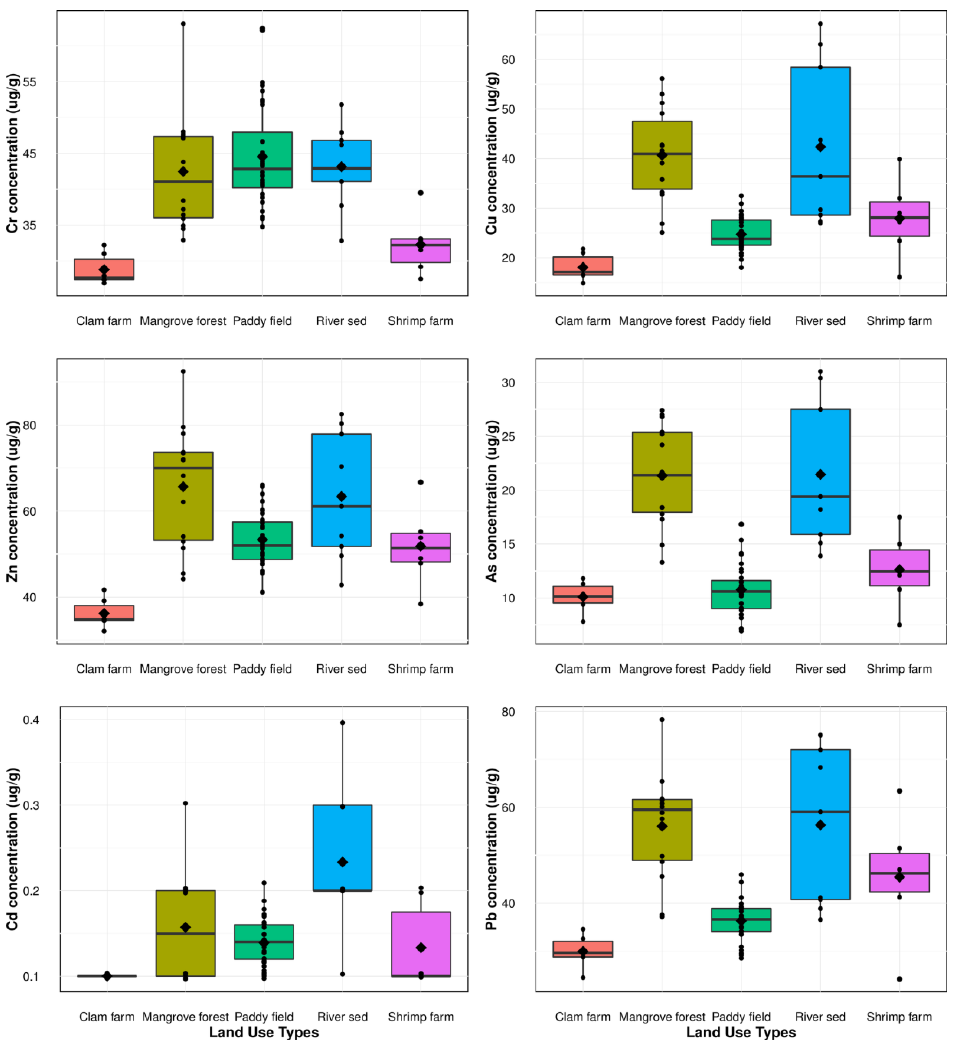
Figure 3. Boxplot of the heavy metal concentrations in soil samples of the five land uses. The black solid line inside the box is the median value; the black rhombus is the mean value; the black dots are individual samples.